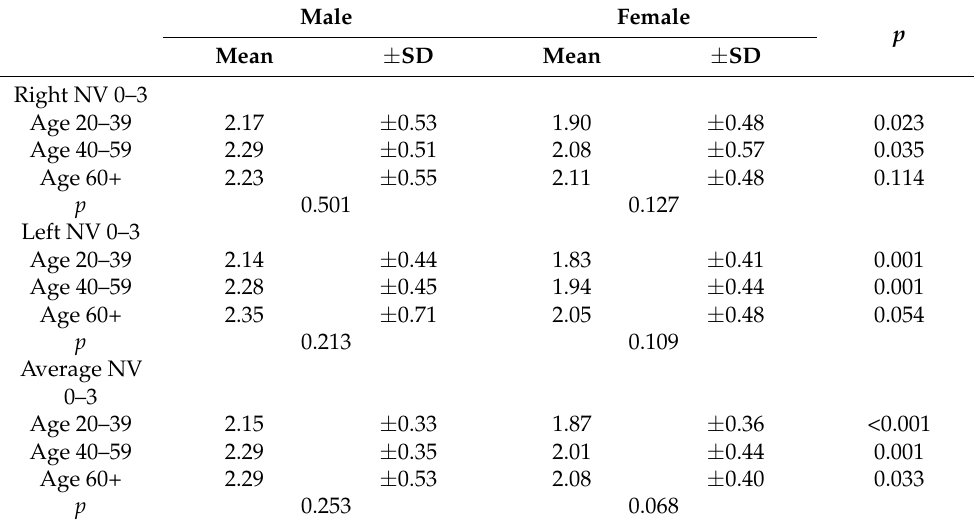
Table 5. Nasal volume (cm 3 ) between the tip of the nosepiece and 3.0 cm into the nasal cavity (NV 0–3).